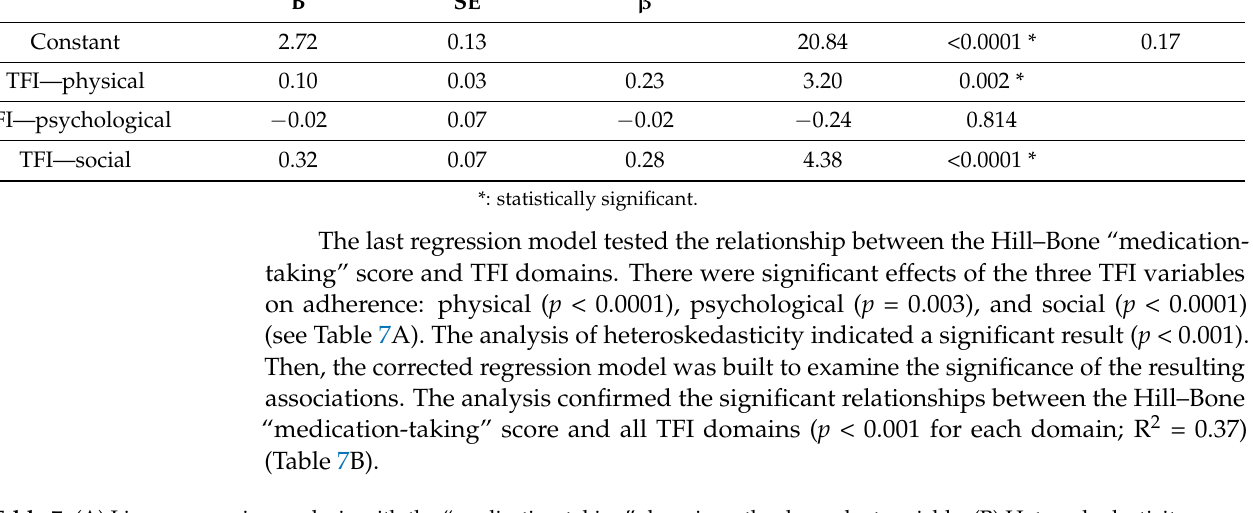
Table 7. (A) Linear regression analysis with the “medication-taking” domain as the dependent variable. (B) Heteroskedasticity- corrected model testing the TFI impact on the Hill–Bone “medication-taking”